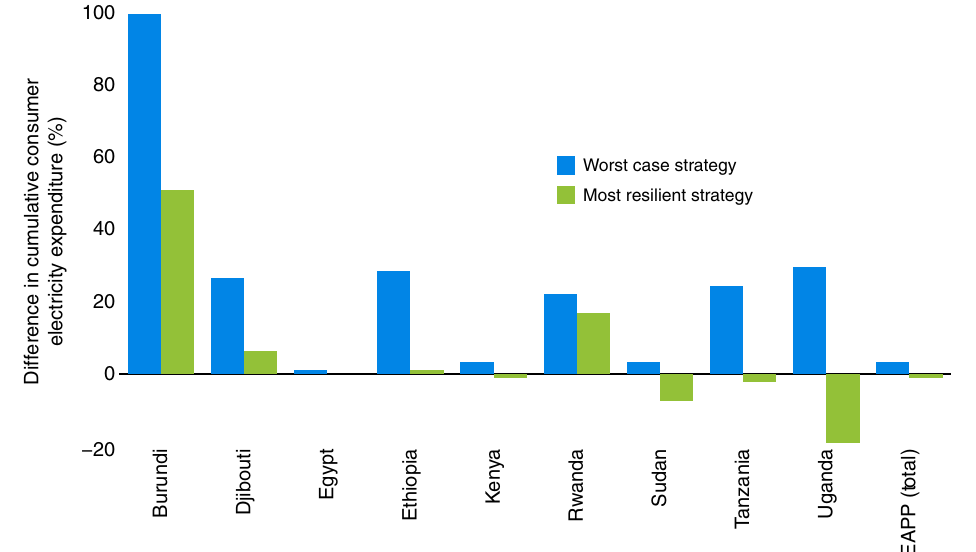
Fig. 4 Impact of adaptation strategies on electricity expenditure. The cumulative consumer electricity expenditure under the most resilient and the worst (no adaptation-driest climate) strategy are compared against the baseline. The zero line (0%) refers to the expenditure in the baseline. The accumulation period is from 2017 –